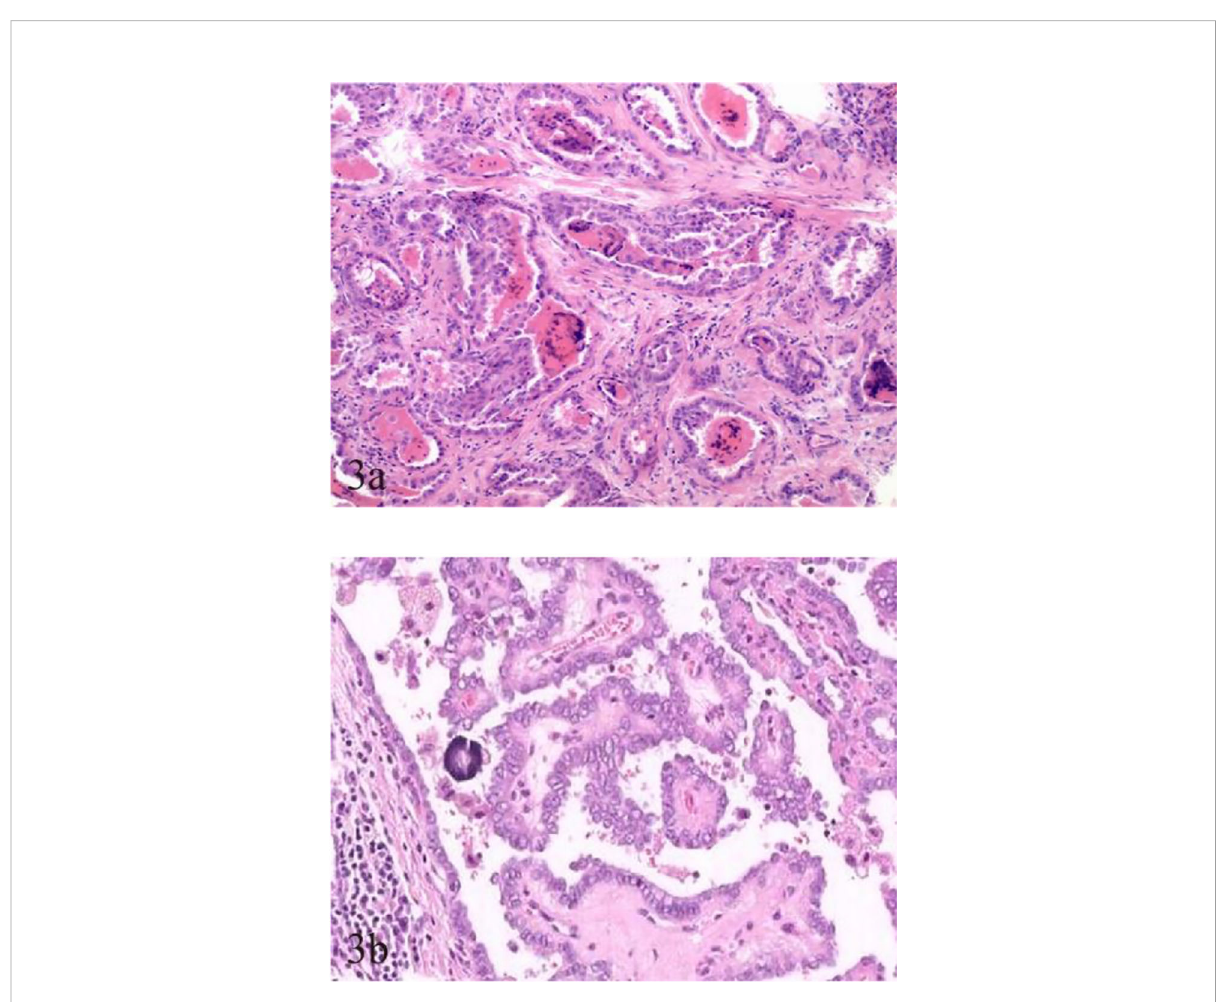
FIGURE 3 Pathological characteristics of TCV-PTMC and C-PTMC. (A) TCV in a 63-year-old woman with an unevenly distributed increased number of cellular fi brocytes and delicate collagenous areas (hematoxylin and eosin staining, ×200). (B) C-PTMC in a 48-year-old man with few evenly distributed fi brocytes and a prominent collagenized stroma (hematoxylin and eosin staining,